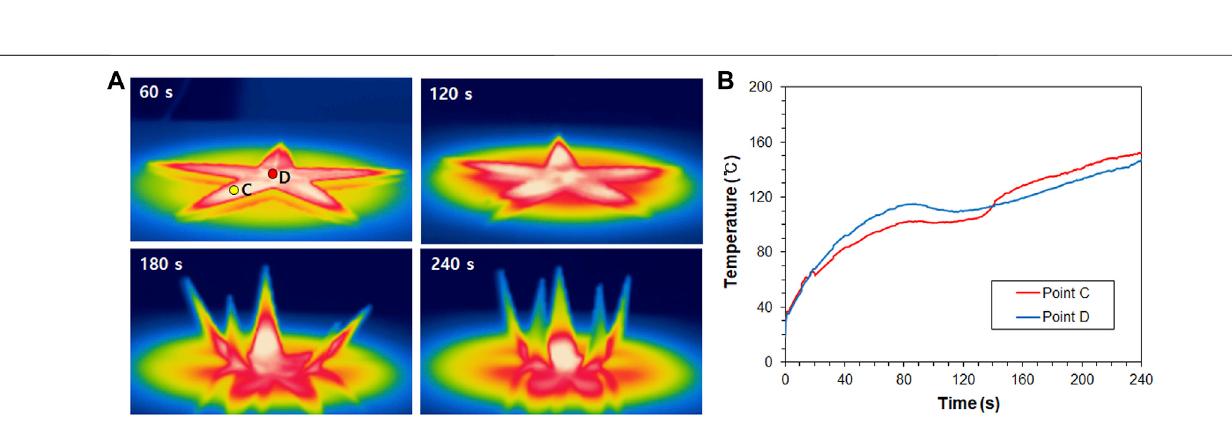
FIGURE 7 | Global shape transformation of the 2D star-shape plate (A) Deformations and the relevant temperature changes (B) Comparison of temperature pro fi les at points C and D.